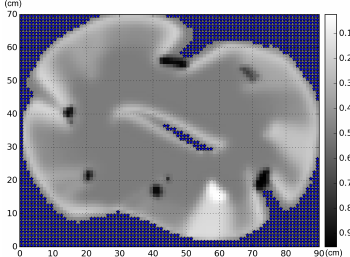
Figure 14. HMM parameter estimation of a 11 (occupied to occupied).